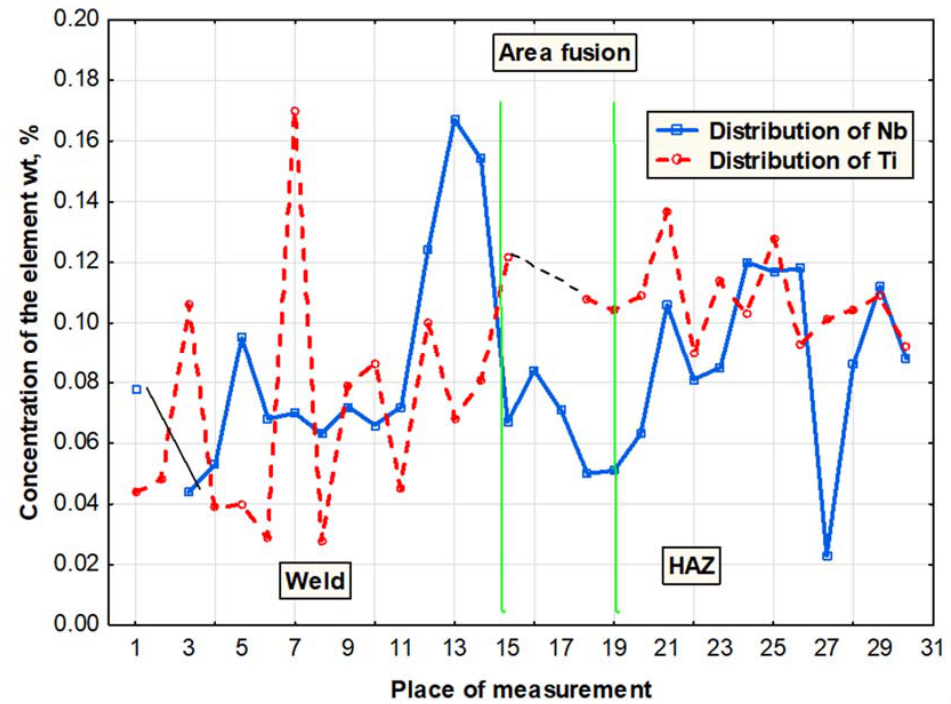
Figure 14. Distribution of Ti and Nb in the fusion area of the laser-welded joint made of steel S700MC.